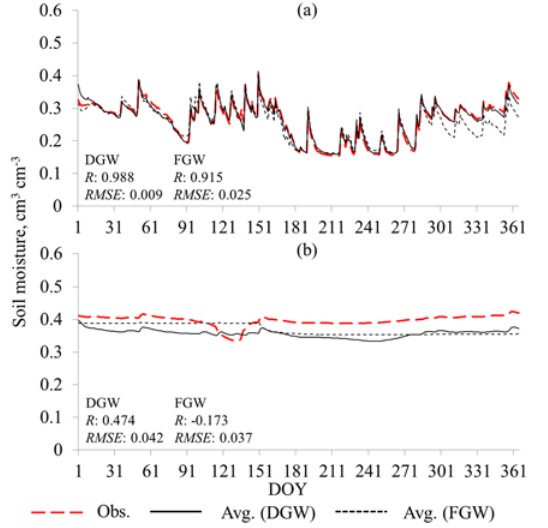
Figure 6. Comparison of observed and ensemble averaged root zone soil moisture dynamics for layered soil column with grass at ARS 136 site in Oklahoma (1997) under synthetic conditions; ( a ) 1st layer at soil depth of 0–60 cm; and ( b ) 2nd layer at soil depth of 60–200 cm. Number in ensemble: 100.